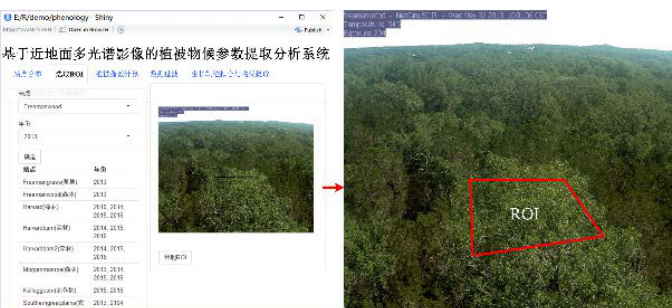
Figure 3. ROI drawing